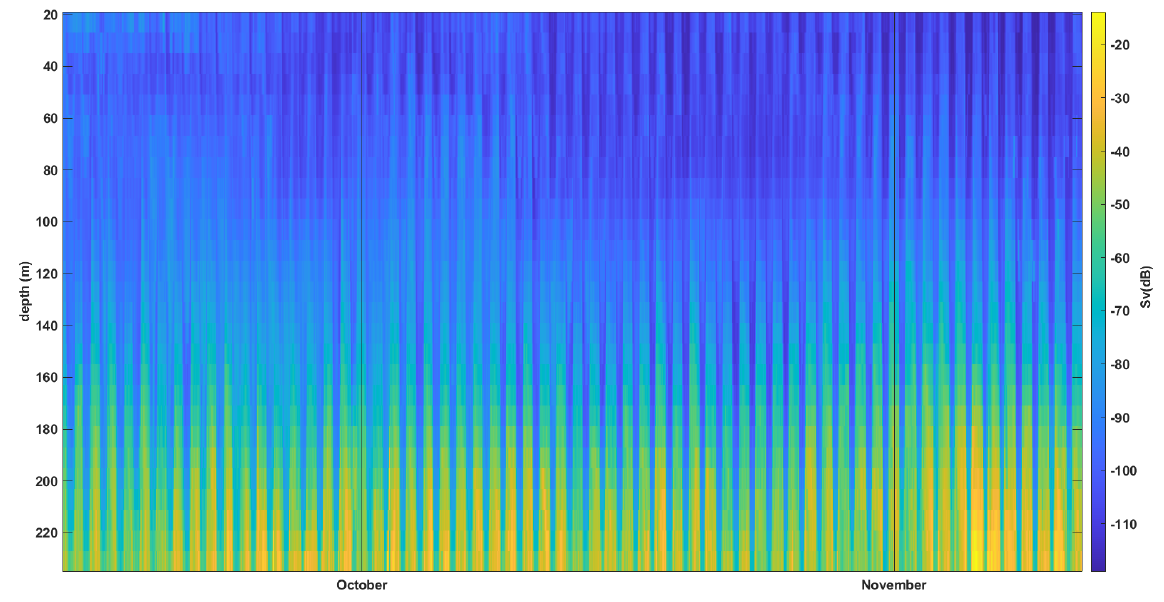
Figure 2. Time series of backscatter strength profile from mooring M2. Data are smoothed with a 5-span moving average over the time.